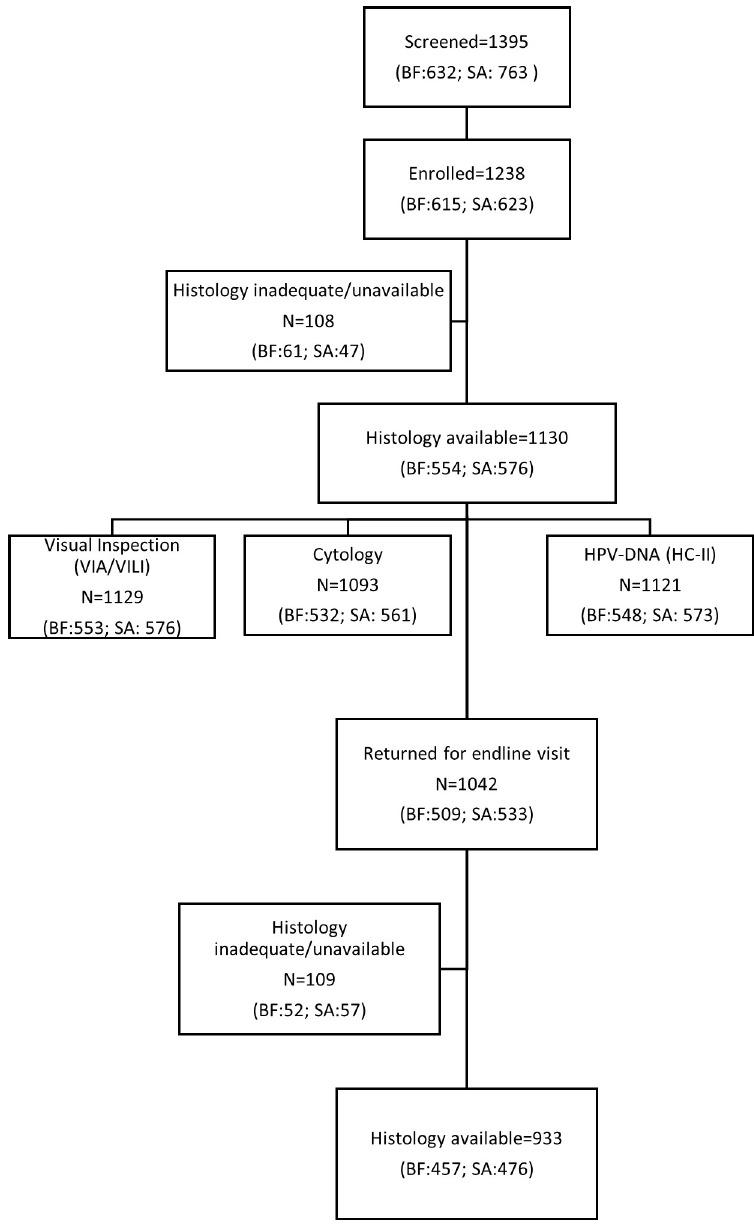
Fig 1. Study flowchart. BF, Burkina Faso; HC-II, Hybrid Capture 2; HPV, human papillomavirus; SA, South Africa; VIA, visual inspection using acetic acid; VILI, visual inspection using Lugol’s